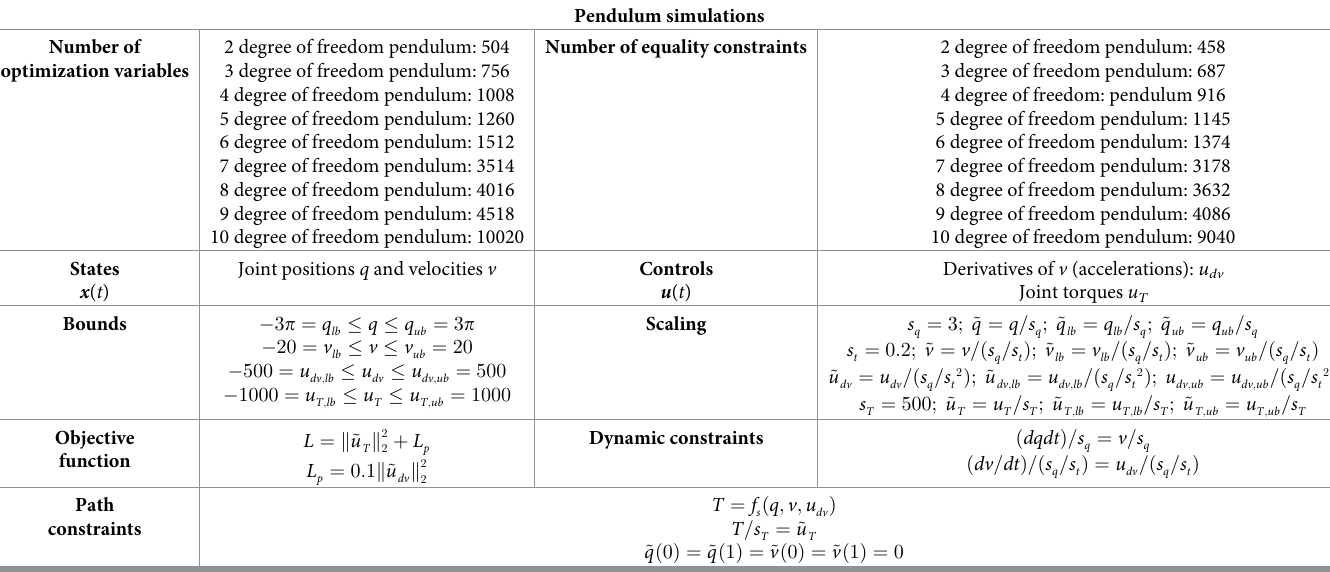
Table 1. Formulation of example